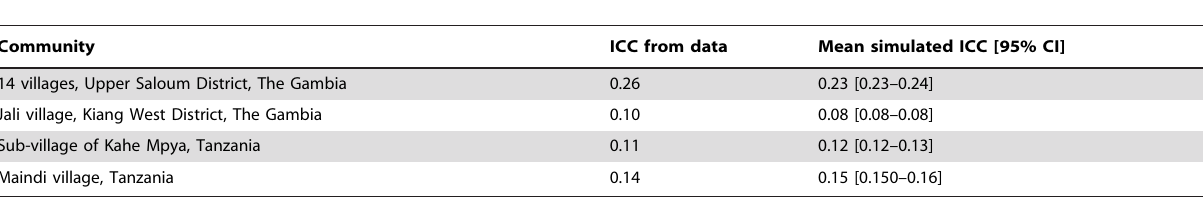
Table 3. Comparison of the ICC from four populations endemic for trachoma with the mean simulated ICC.